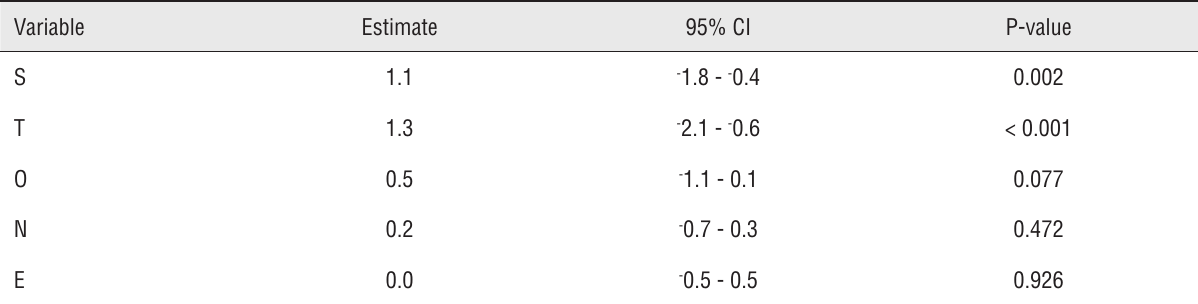
Table 2 - Multivariate Logistic Regression Model.